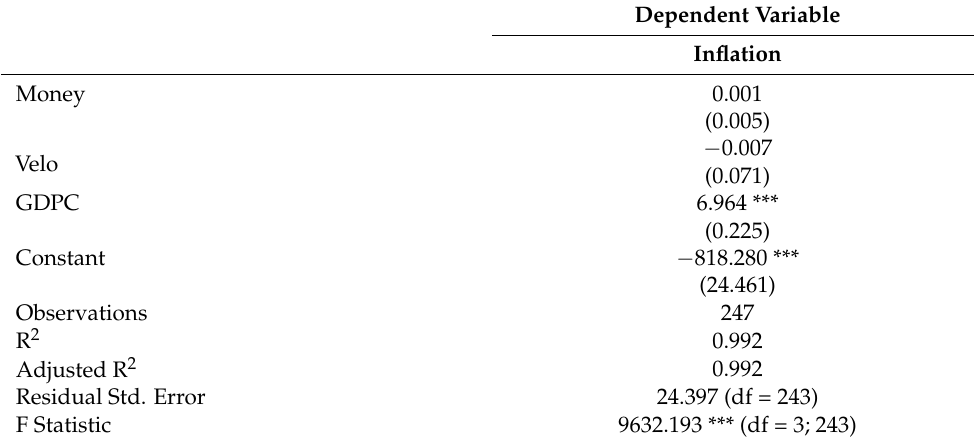
Table 8. Inflation estimation including GDP in the dependent variables.